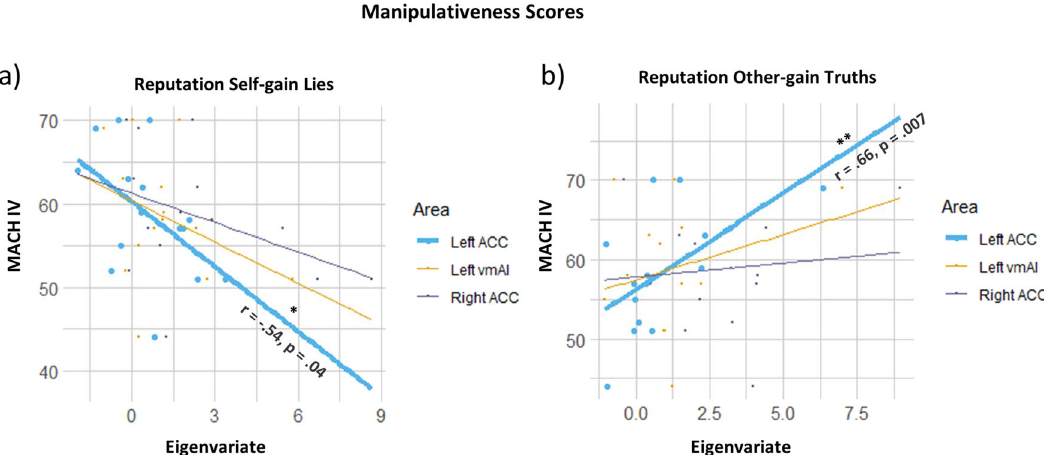
Fig. 4 Correlations of levels of manipulative traits and decision-related brain activity in the regions of interest. a Correlation of averaged beta-values in three brain areas (LACC, LvmAI, RACC) during self-gain lies with reputation risk and Machiavellian scores. b Correlation of averaged beta-values in three brain areas (LACC, LvmAI, RACC) during other-gain truths with reputation risk and Machiavellian scores. The line plots in bold depict signi fi cance ( N = 15). ACC anterior cingulate cortex, vmAI ventromedial anterior